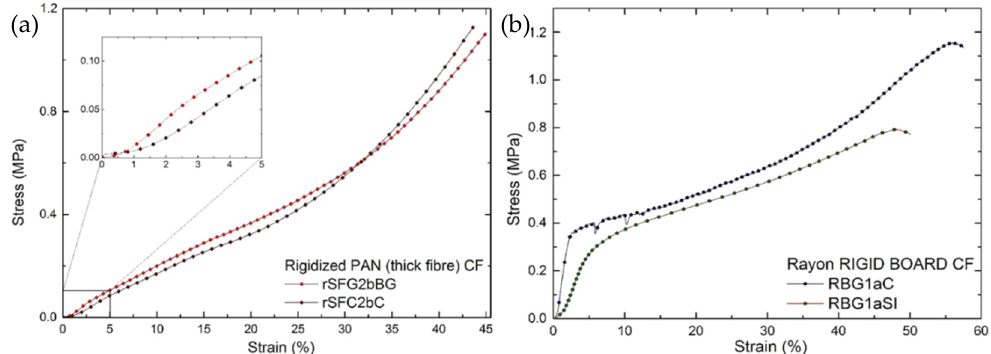
Figure 4. Stress-strain characteristics of: ( a ) rigidized PAN-derived soft CFs and ( b ) Rayon-derived rigid boards, subjected to uniaxial compression along their OP ( z ) direction. The inset in ( a ) is a zoom on the initial linear deformation.